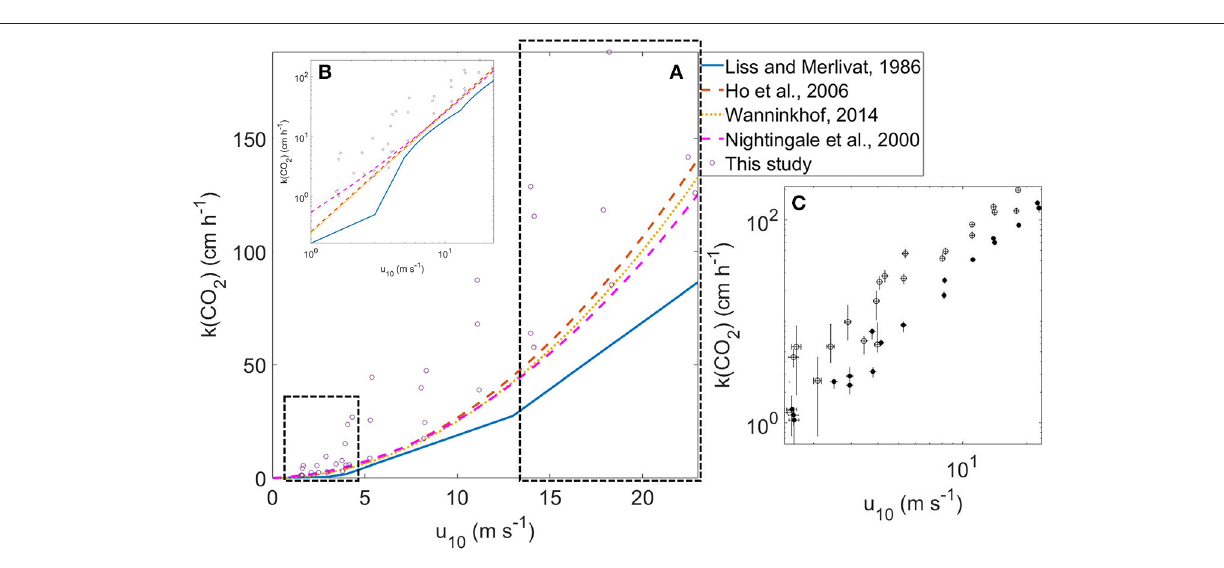
FIGURE 4 | (A) k(CO 2 ) vs. wind scatterplot in linear axis in comparison to other parametrizations: Liss and Merlivat (1986), Ho et al. (2006), Wanninkhof (2014), and Nightingale et al. (2000), all scaled to a Schmidt number of 660. The data in the black box are the empirical data added in the lower and higher wind speeds where known parametrizations fall short. The insert shows the same information, but uses a double logarithmic scale (B) . (C) Relationship between the gas transfer velocities for CO 2 and wind speeds for enriched p CO 2 conditions (solid circles) and non-enriched p CO 2 conditions (open data points) with asymmetric error bars in double logarithmic